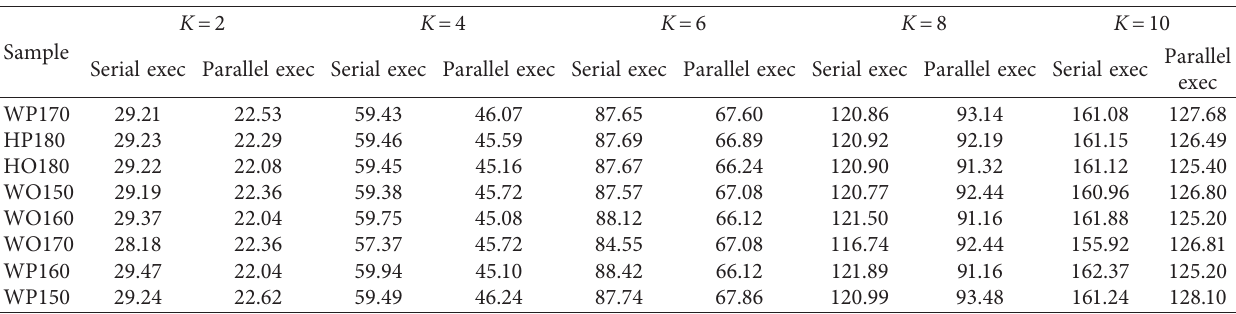
Figure 15: Execution time analysis by varying number of threads. Table 6: Serial v/s parallel execution time (sec) for dry condition.